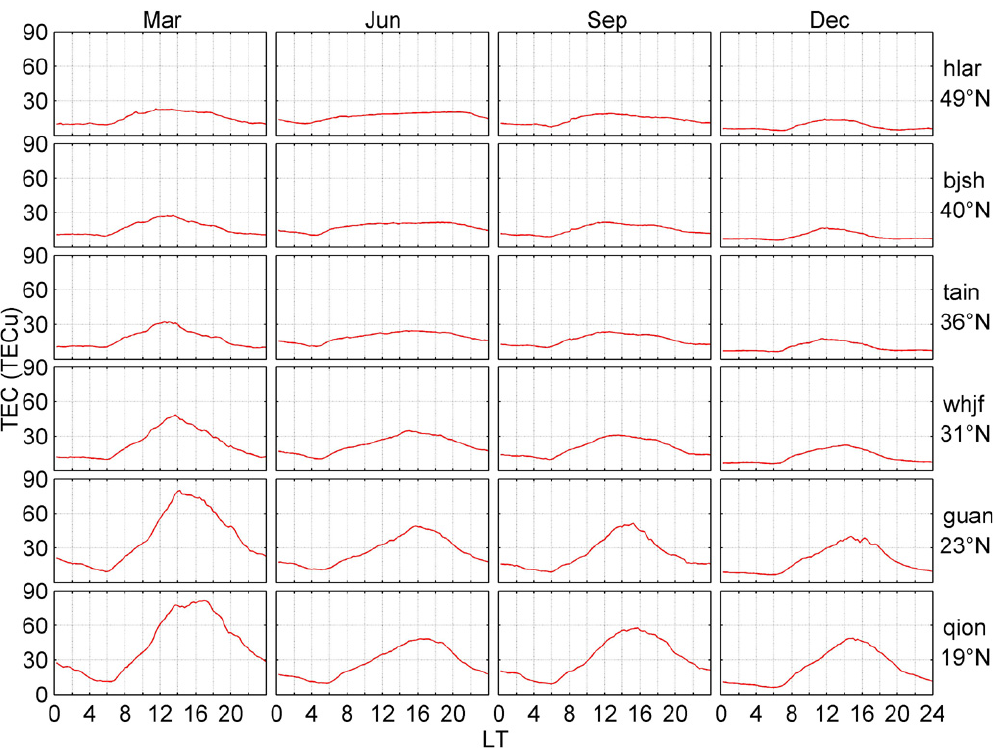
Fig. 4. Diurnal variations of TEC (median) in four months (March, June, September and December) in 2004 at 6 GPS sites along 120 ◦